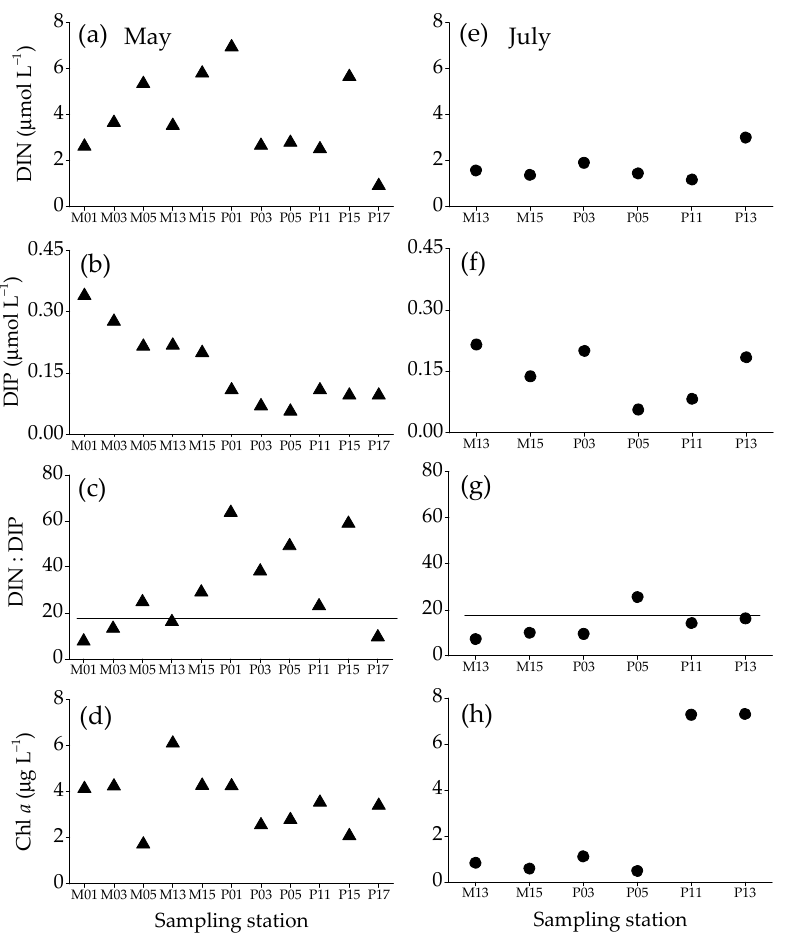
Figure 3. Dissolved inorganic nitrogen (DIN) concentration ( a , e ), dissolved inorganic phosphorus (DIP) concentration ( b , f ), DIN:DIP ratio ( c , g ), and chlorophyll a (Chl a ) concentration ( d , h ) in the surface water of the Taiwan Strait during the cruises in May ( left ) and July ( right ) 2019. Horizontal lines in panels ( c , g ) show the Redfield ratio of 16:1.